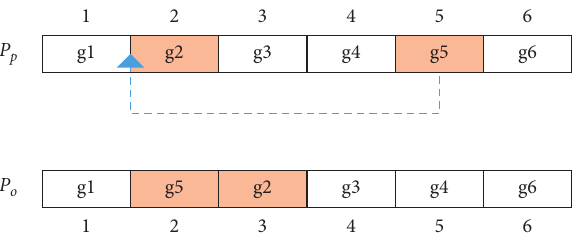
Figure 6: Schematic diagram of forward insert.